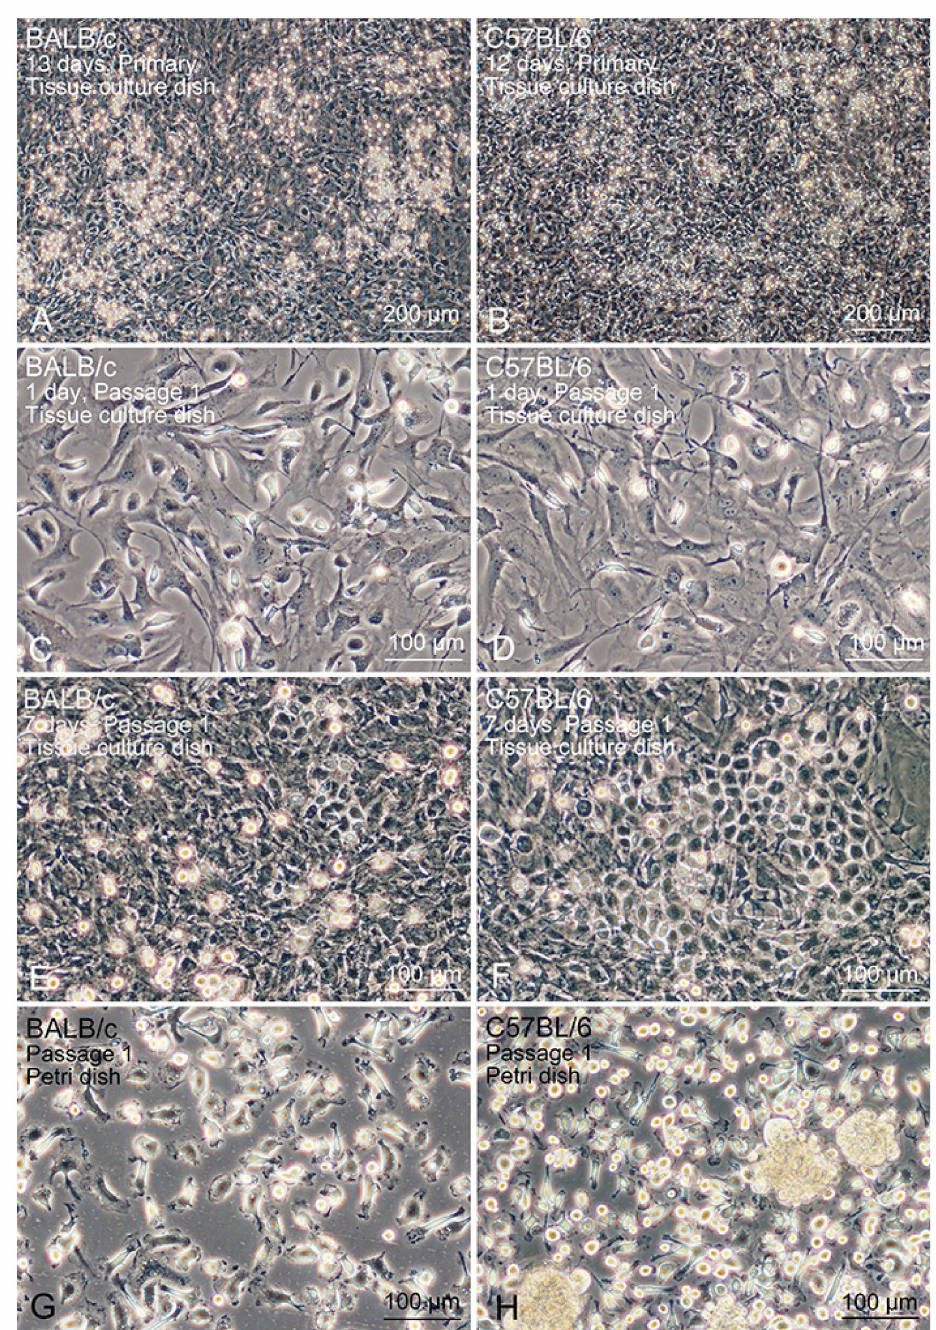
Figure 1. The propagation of lung tissue-resident Mø in co-culture and subculture with lung intersti- tial cells in tissue-culture dishes and their segregation on bacteriological Petri dishes. Right panels ( A , C , E , G ) and left panels ( B , D , F , H ) show the lung cells derived from BALB/c and C57BL/6 mice, respectively. ( A , B ): Primary lung cells cultured for the indicated days after seeding in a tissue-culture dish. ( C , D ): Lung cells after passage 1 conducted 1 day after seeding in a tissue-culture dish. ( E , F ): Lung cells after passage 1 conducted 7 days after seeding in a tissue-culture dish. ( G , H ): lung tissue-resident Mø in bacteriological Petri dishes. Mø selectively adhering to the dish surface and nonadherent cells forming cell aggregates in the ( H ) panel. Cell aggregates were removed by washing with a conditioned medium, as can be seen in the ( G )